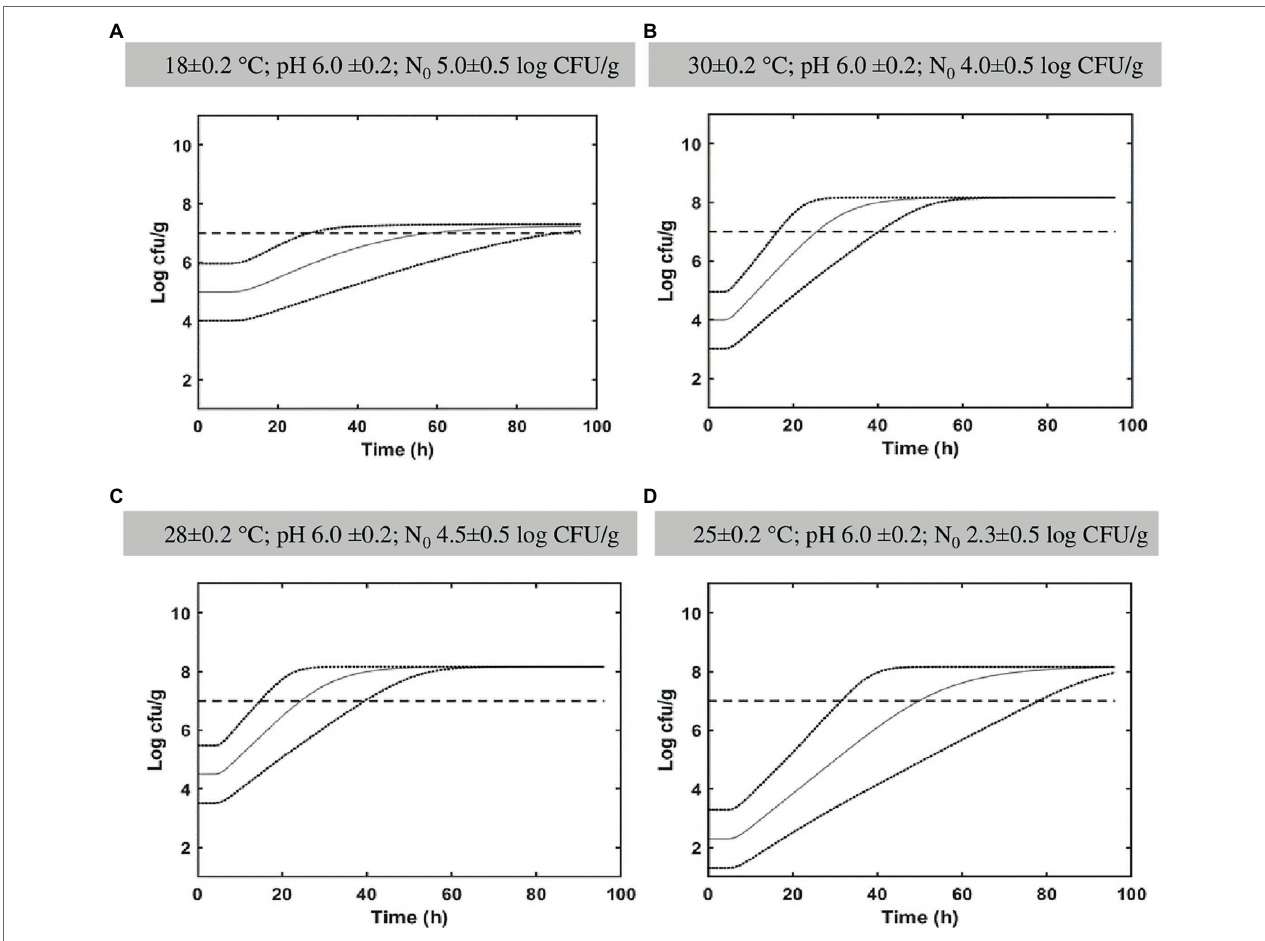
FIGURE 4 | In silico growth simulations and probability of Lacticaseibacillus paracasei to reach the targeted probiotic level fixed at 7 log 10 CFU/g in cabbage. Simulations were obtained in cabbage during 4 days at different conditions ( A : 18 ° C, pH 6.0, N 0 5.0; B : 30 ° C, pH 6.0, N 0 4.0; C : 28 ° C, pH 6, N 0 4.5; D : 25 ° C, pH 6.0, N 0 2.30). The distribution of Lacticaseibacillus paracasei population is indicated together with a targeted probiotic level threshold fixed at 7 log 10